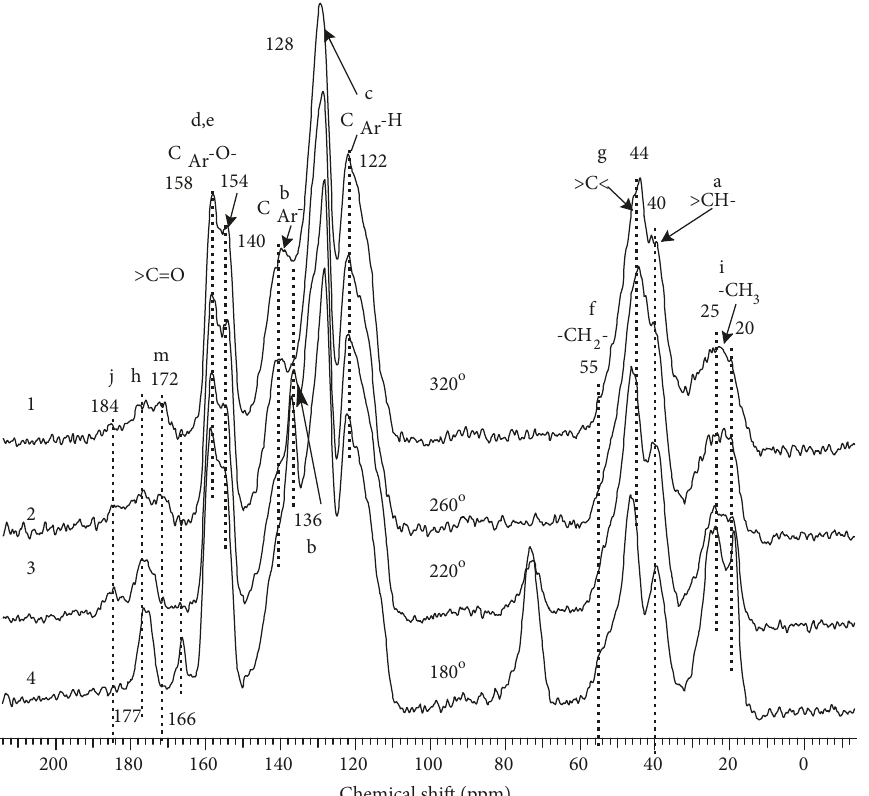
Figure 6: 13 С NMR spectra of samples of neat ROL-II (I-IV) resins cured according to the thermal regime with T to 320 ° С .